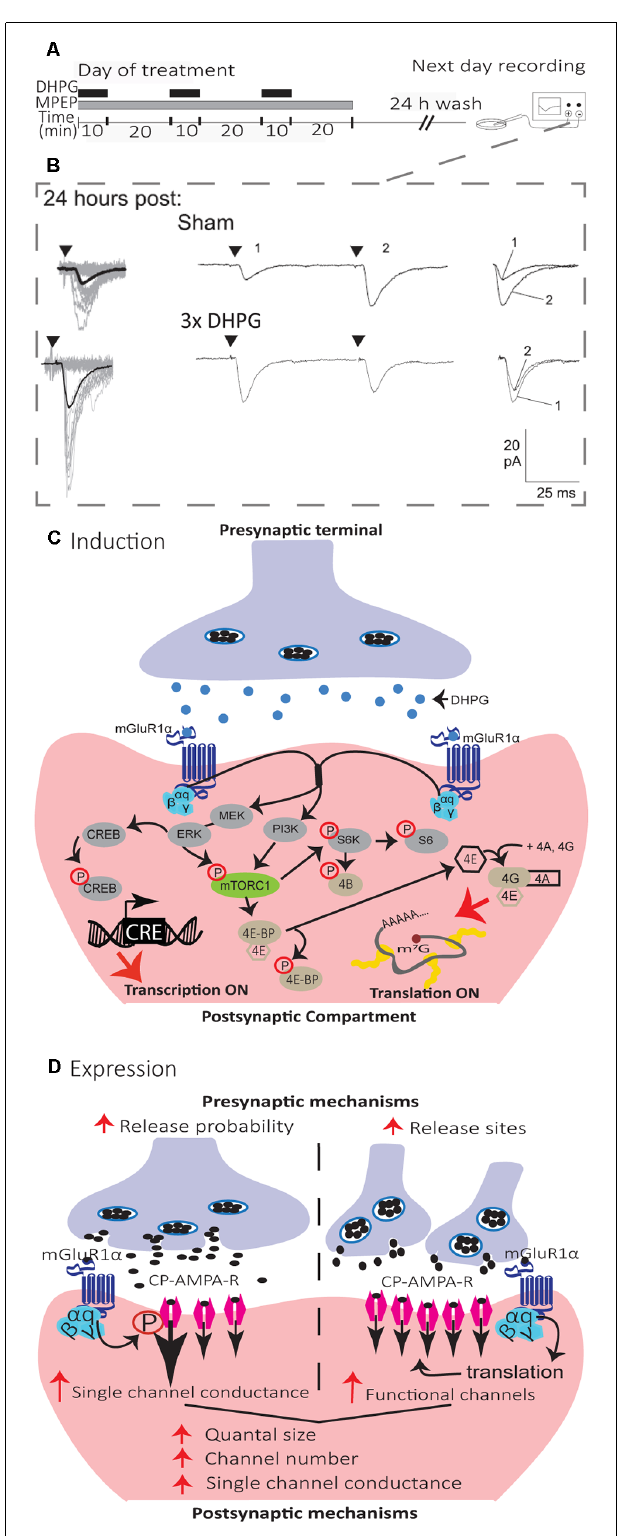
FIGURE 4 | Mechanisms of induction and expression of L-LTP mGluR1 in SOM interneurons. (A) Schematics of induction and recording protocol.